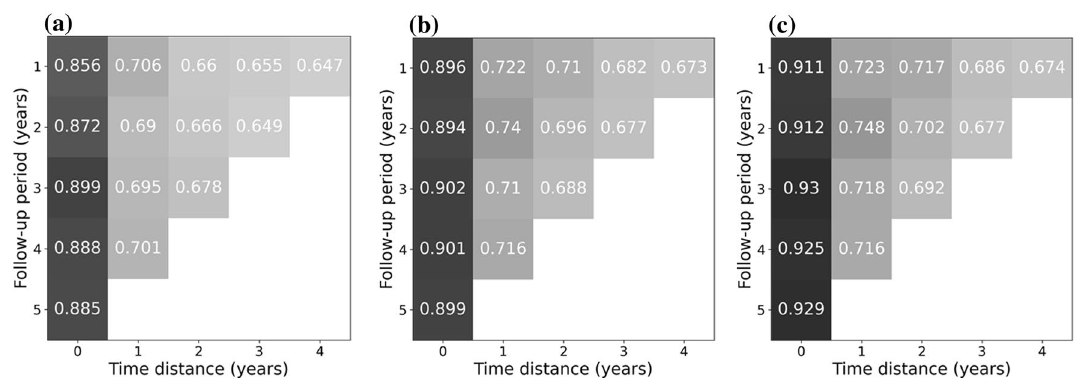
Figure 2. Balanced accuracy of predicting death using Logistic Regression ( a ), Random Forests ( b ) and Extreme Gradient Boosting ( c ). Models built on different follow-up periods (from 1 to 5 years) in which covariates may have occurred, and used different time distances (time between exposure and event